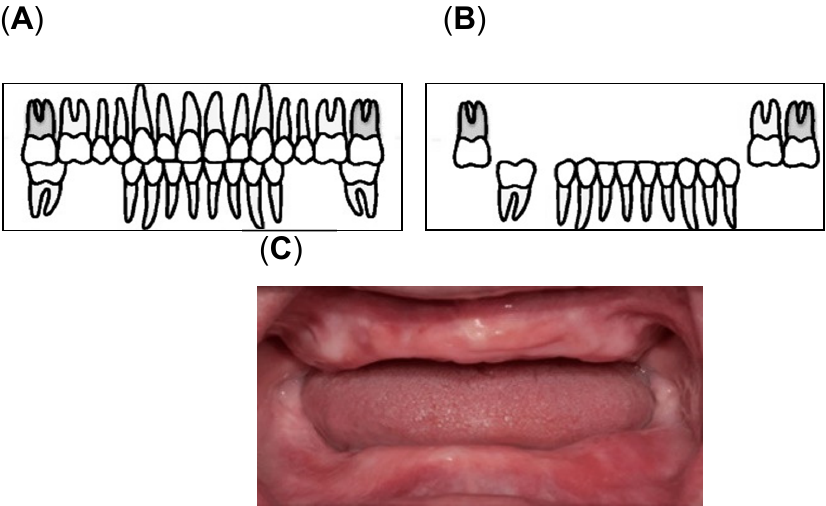
Figure 2. Classification of the Posterior Occlusal Contact: ( A ) With posterior occlusion (with PO) group consisting of Eichner A1, A2, A3, B1, B2, and B3; ( B ) Without Posterior occlusion (without PO) group consisting of Eichner B4, C1, and C2 [52] ; ( C ) the edentulous group [53]. Oral moisture was assessed twice by measuring the wetness on the dorsum of the tongue and buccal mucosa using an oral moisture meter (Mucus ® , LIFE Co., Ltd., Saitama, Japan). A dielectrophoretic impedance measurement method (Panasonic Healthcare Co., Tokyo, Japan) was used to evaluate the bacterial count on the tongue surface [54,55]. The machine rates bacterial counts from levels 1 to 7 [56]; level 1, 2, 3, 4, 5, 6, and 7 indicate the bacterial counts of < 10 5 , ≥ 10 5 and < 10 6 , ≥ 10 6 and < 3.16 × 10 6 , ≥ 3.16 × 10 6 and < 10 7 , ≥ 10 7 and < 3.16 × 10 7 , ≥ 3.16 × 10 7 , < 10 8 , and ≥ 10 8 , respectively [49].